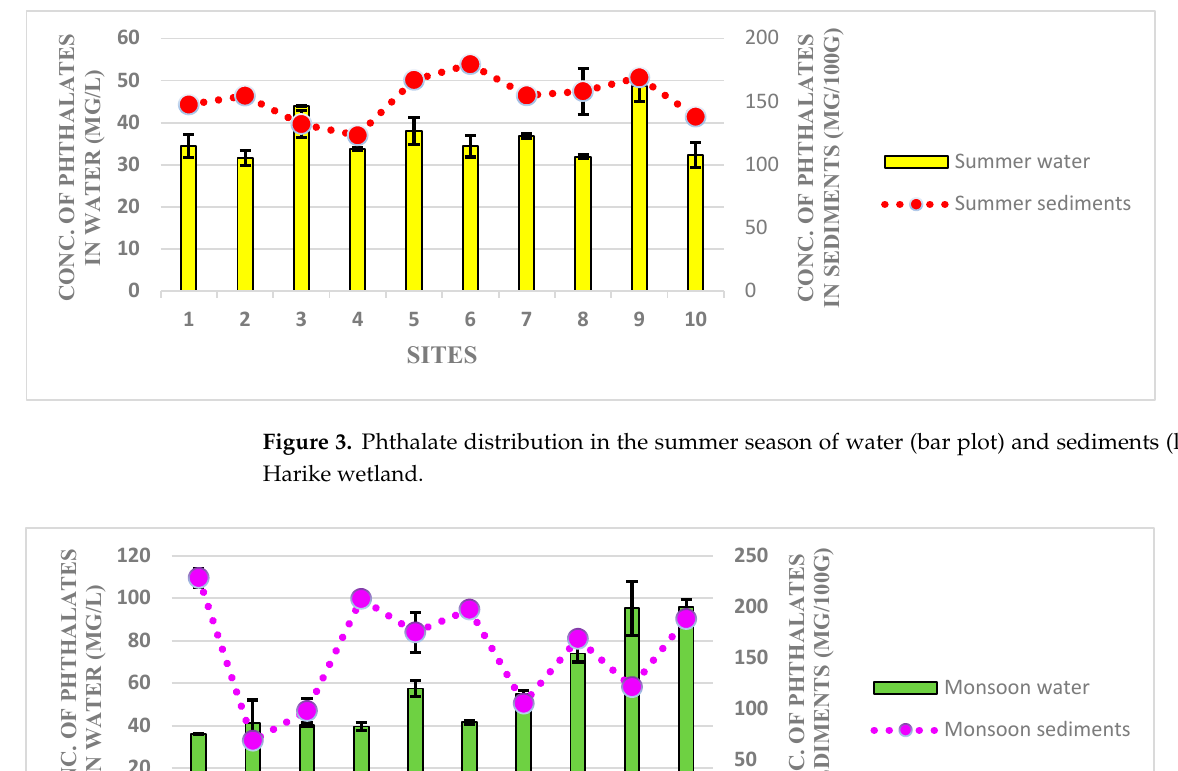
Figure 2. Phthalate distribution in the winter season of water (bar plot) and sediments (line) of Harike wetland.